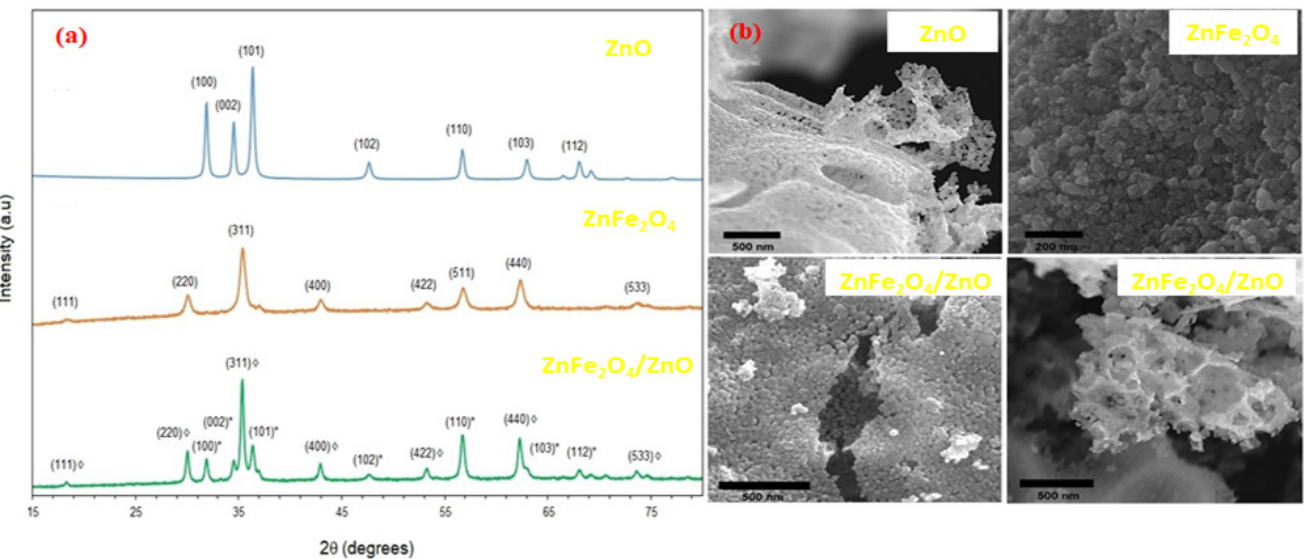
Figure 6. ( a ) XRD structural and ( b ) SEM micrographs of ZnO, ZnFe 2 O 4, and magnetic ZnFe 2 O 4 /ZnO nanocomposites with different molar ratios (1/1, 1/8) [17]. ♦ corresponds to ZnFe 2 O 4 and * corresponds to ZnO. Republished with permission from Wiley.